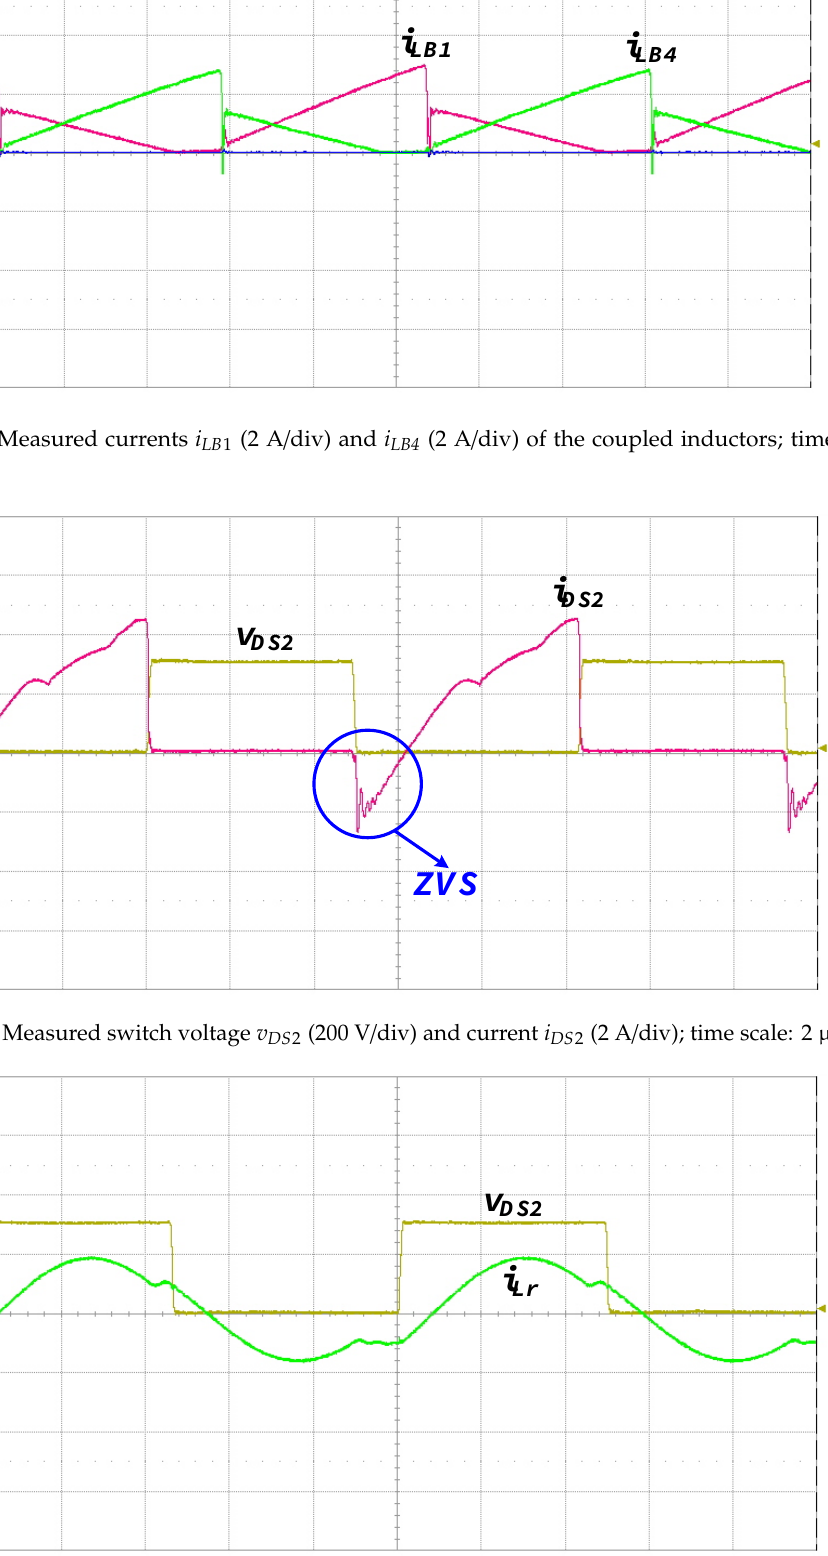
Figure 10. Measured switch voltage v DS 2 (200 V/div) and current i Lr (2 A/div); time scale: 2 μs/div.